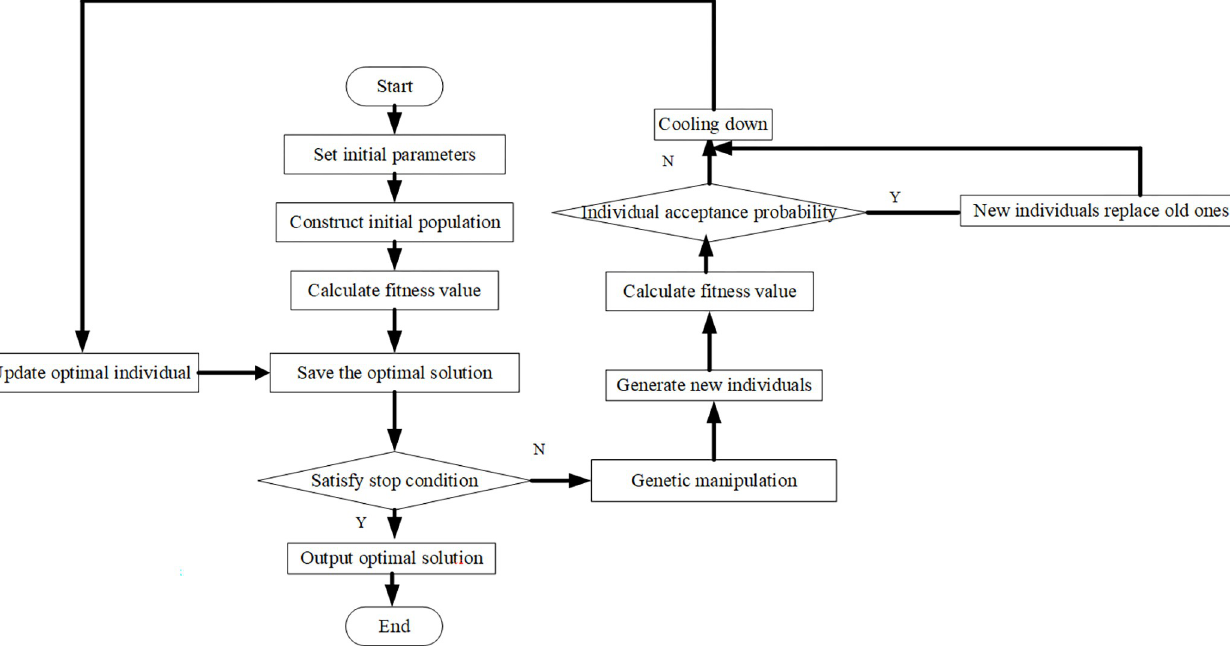
Fig 6. Flowchart of